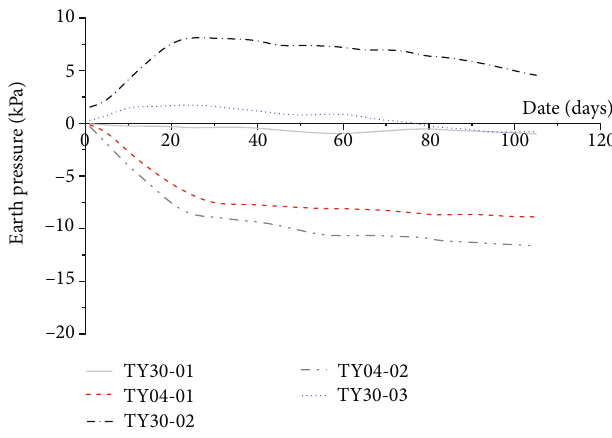
Figure 10: Time histories of earth pressure at various monitoring